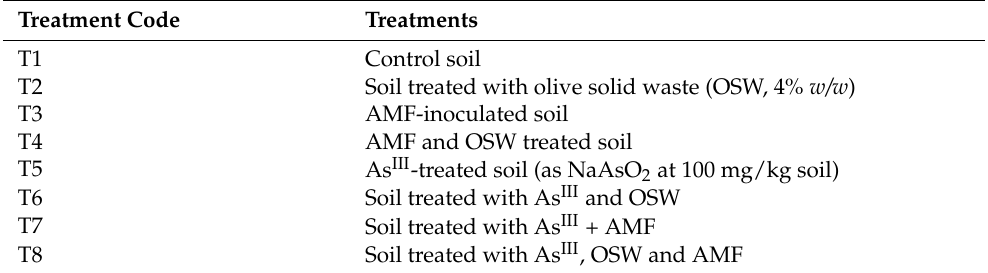
Table 2. A list of applied